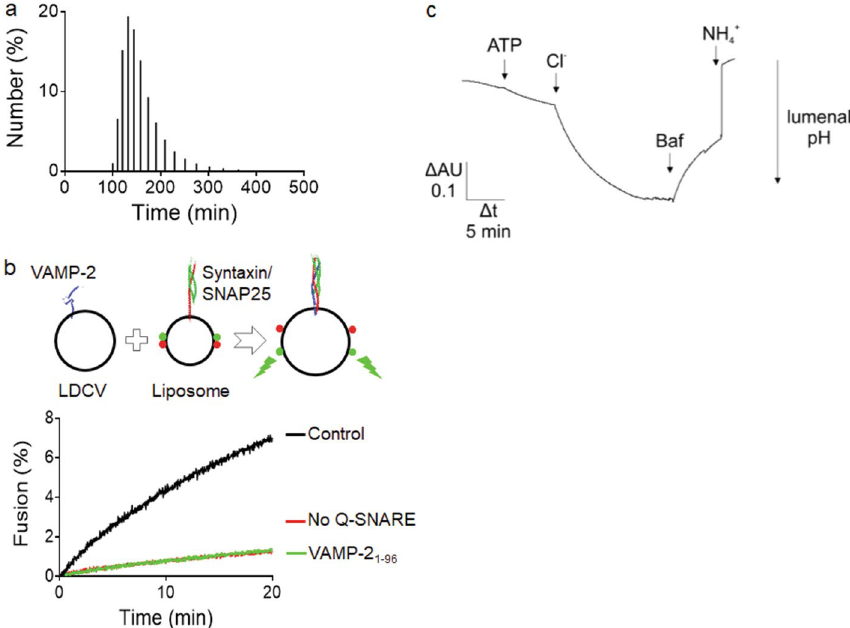
Figure 4. Biophysical and biochemical properties of purified LDCVs. ( a ) Size distribution of purified LDCVs analyzed using dynamic light scattering. The histogram shows the numbers as percentage of total. Average diameter of LDCVs is 153.7 nm, with a standard deviation (SD) of 42.2 nm. ( b ) Fusion of LDCVs with liposomes containing SNARE acceptor complexes. Fusion was measured by dequenching of labeled membrane lipids (lipid mixing) 18,22,28 (top). Plasma membrane-mimicking liposomes contain phospholipids labelled with NBD (green fluorescence) and rhodamine (red fluorescence). The stabilized Q-SNARE complex (syntaxin-1A and SNAP-25A) called the deltaN complex 23 is reconstituted in liposomes that mimic the plasma membrane. Fluorescence resonance energy transfer (FRET) between the two fluorophore-labeled lipids is reduced after LDCV fusion due to lipid dilution by unlabeled lipids of LDCVs, thus de-quenching the donor fluorescence. Soluble synaptobrevin-2 (VAMP-2 1-96 ) and omission of SNAREs in liposomes prevented lipid mixing (bottom). Fluorescence values are normalized as a percentage value of the maximum donor fluorescence induced by 0.1% (vol/vol) Triton X-100 (TX-100) detergent treatment at the end of experiments. ( c ) ATP and Cl - dependent acidification in LDCVs. LDCV acidification was monitored using 1 mM acridine orange as a reporter dye. The reaction was started by the addition of 1.2 mM MgATP followed by 50 mM KCl. Addition of 0.2 µM of the V-ATPase inhibitor Bafilomycin results in luminal re-alkalinization, indicating V-ATPase-specific proton pumping. The reaction was stopped by adding 15 mM (NH 4 ) 2 SO 4 which equilibrates the luminal pH with that of the